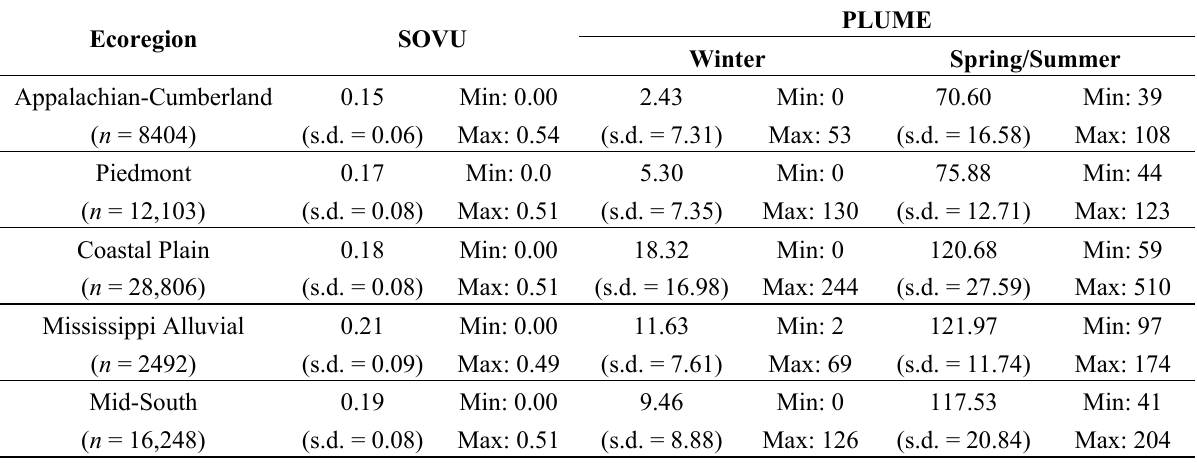
Table 2. Mean Census Block Group Values for Social Vulnerability and Number of Smoke